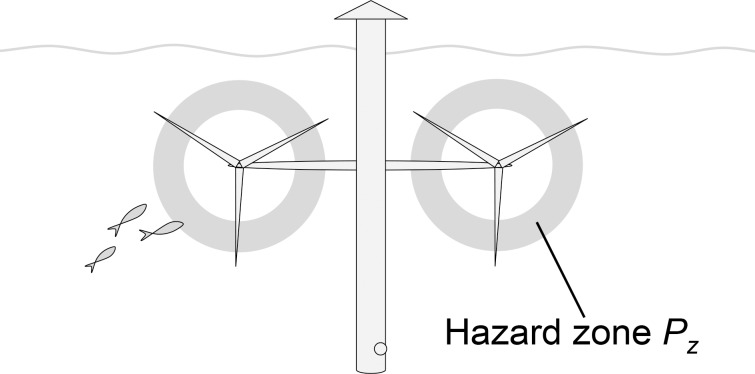
Conceptual representation of the hazard zone (P
z).
P
z is the hazardous part of the rotor as a proportion of the full rotor swept disc.